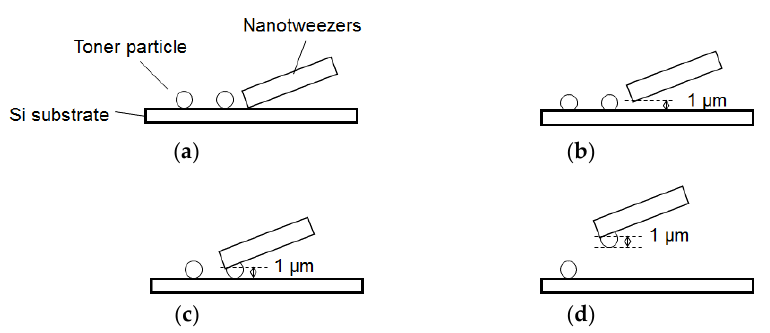
Figure 2. Procedure for picking up a particle: ( a ) Form contact between the nanotweezers and the Si substrate; ( b ) Move the nanotweezers upward by 1 μm; ( c ) Move nanotweezers horizontally and grip the particle; ( d ) Pick up the particle.